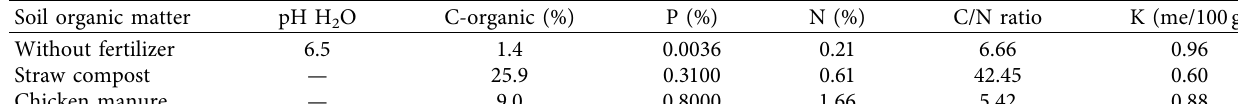
Table 6: Chemical properties of soil and organic matter.